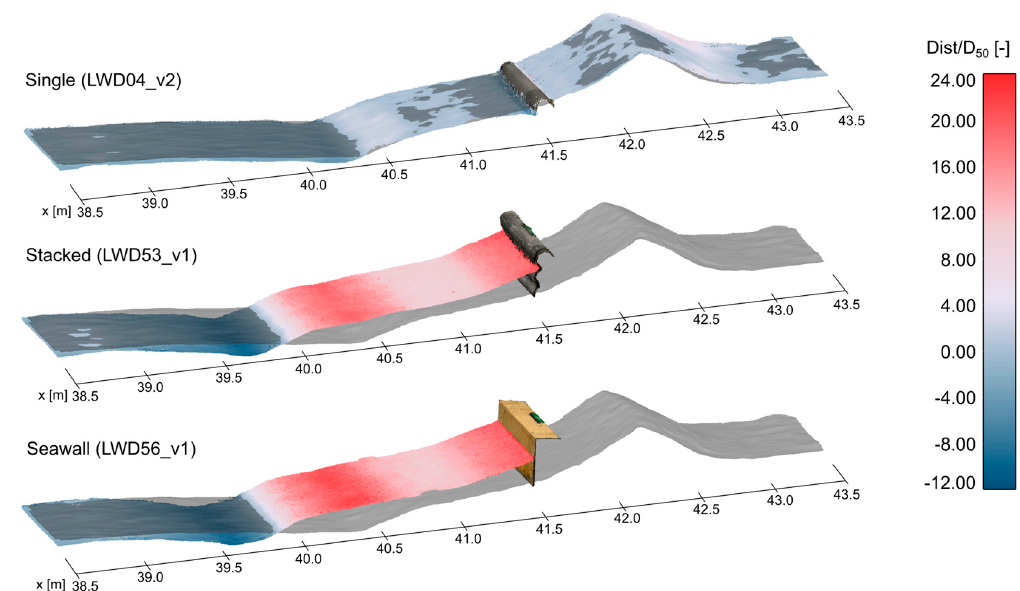
Figure 11. Beach profile changes for each structure configuration in relation to the beach profile with No Structures (grey) under large wave conditions (Tp = 2.51 s, Hs = 0.20 m).